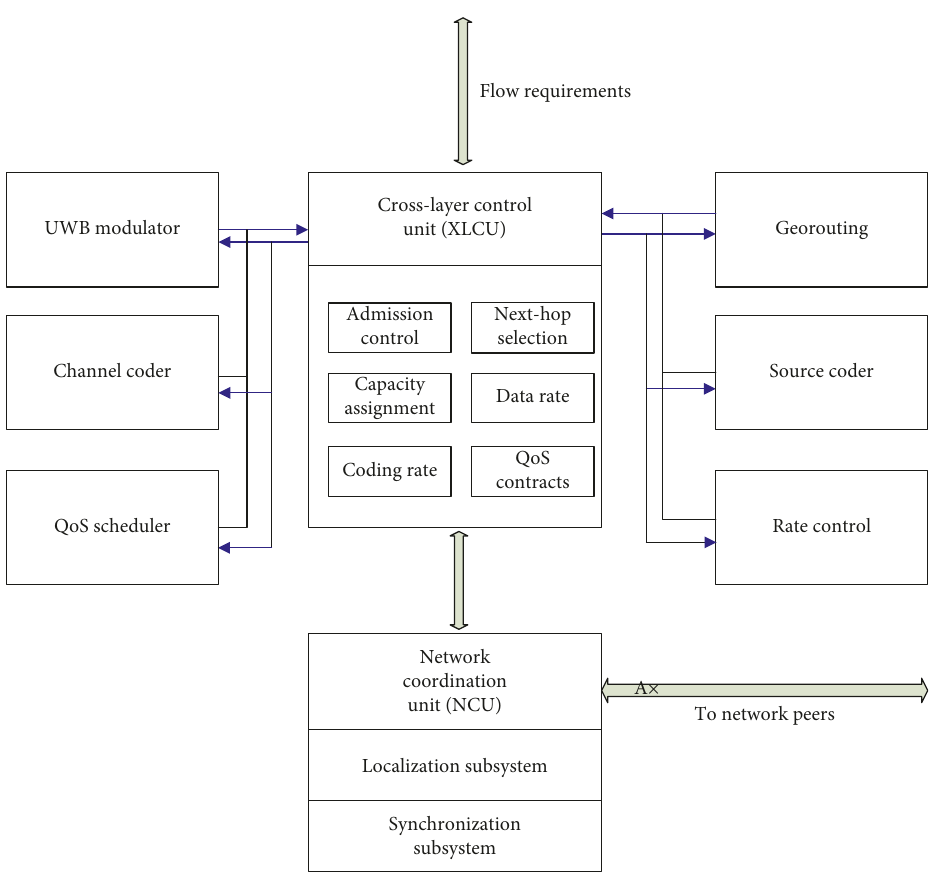
Figure 8: Cross-layer controller